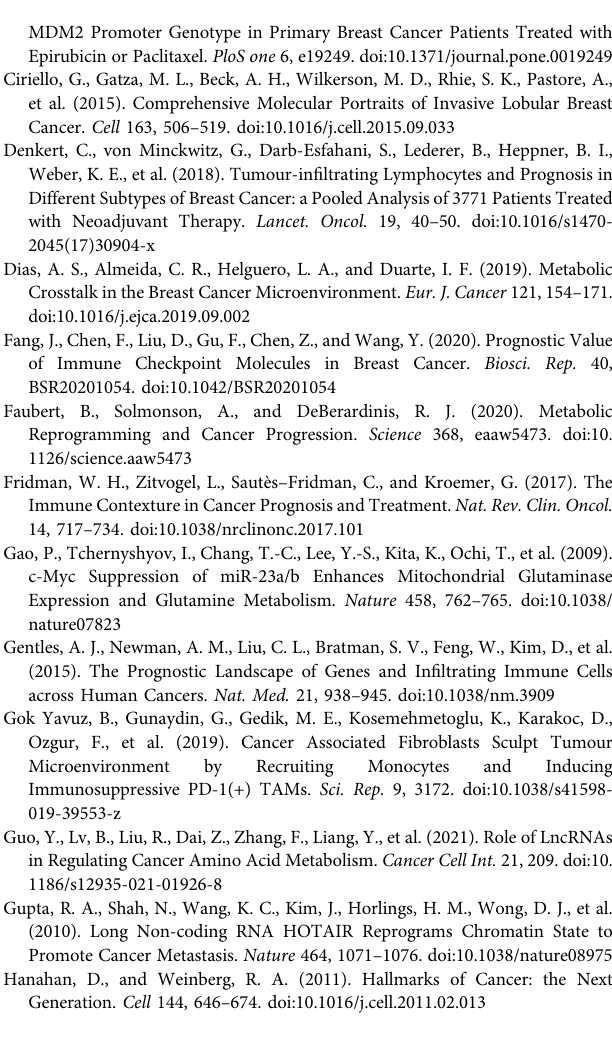
Supplementary Figure S1 | Validation of the risk score in the validation set and the complete TCGA data set. (A) K – M analysis in the validation set. (B) K – M analysis in thecompleteTCGAdataset. (C) Time-dependentROCanalysisinthevalidationset. (D) Time-dependent ROC analysis in the complete TCGA data set. Supplementary Figure S2 | AAM-related lncRNA signature, 11-lncRNA signature (Shen et al., 2020), 11 (2)-lncRNA signature(Li et al., 2021b) , and eight-lncRNA signature(Zhu et al., 2021), respectively, based on TCGA. (A – D) Respective Kaplan – Meier curve results, (E – H) respective AUC for the prediction of the 1-, 3- Supplementary Figure S3 | Heatmap for immune responses based on CIBERSORT, ESTIMATE, MCPcounter, ssGSEA, and TIMER algorithms among high and low risk